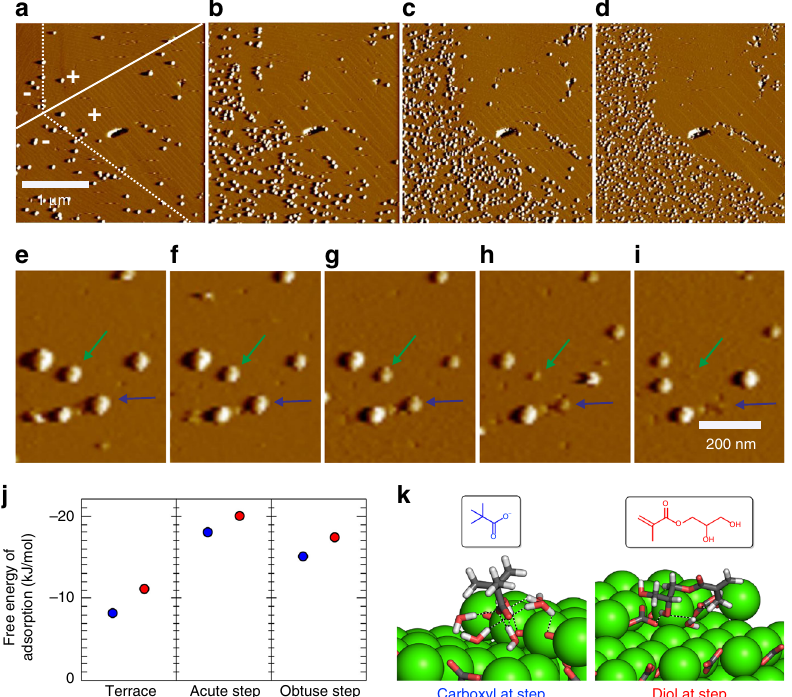
Fig. 10 Occlusion mechanism studied by AFM and molecular dynamic simulations. AFM peak force error images of calcite crystals grown in situ in the presence of 14 nm PGMA-NPs in a liquid cell. a – d Time sequence images taken at a 4.5, b 9, c 13.5, and d 18 min after the introduction of the PGMA-NPs to the liquid cell. The images showed that NPs are weakly absorbed to the calcite surface with a preference for the acute step edges and surface defects. Over time there was an increase in the number density of NPs on the surface. e – i Time sequence images showing the incorporation of the NPs into calcite. The green and blue arrows indicate two examples of NPs that were incorporated during imaging, where images were collected in 3 min intervals. j , k Molecular dynamic simulations. j Adsorption free energies of the three molecules shown to the (104) terrace, and acute and obtuse steps. k The molecular con fi gurations show the stable binding states of each molecule to the acute step. The colours are green (calcium), dark grey (carbon), red (oxygen), and light grey (hydrogen). Only the shared solvent is rendered, with hydrogen bonds shown as dashed